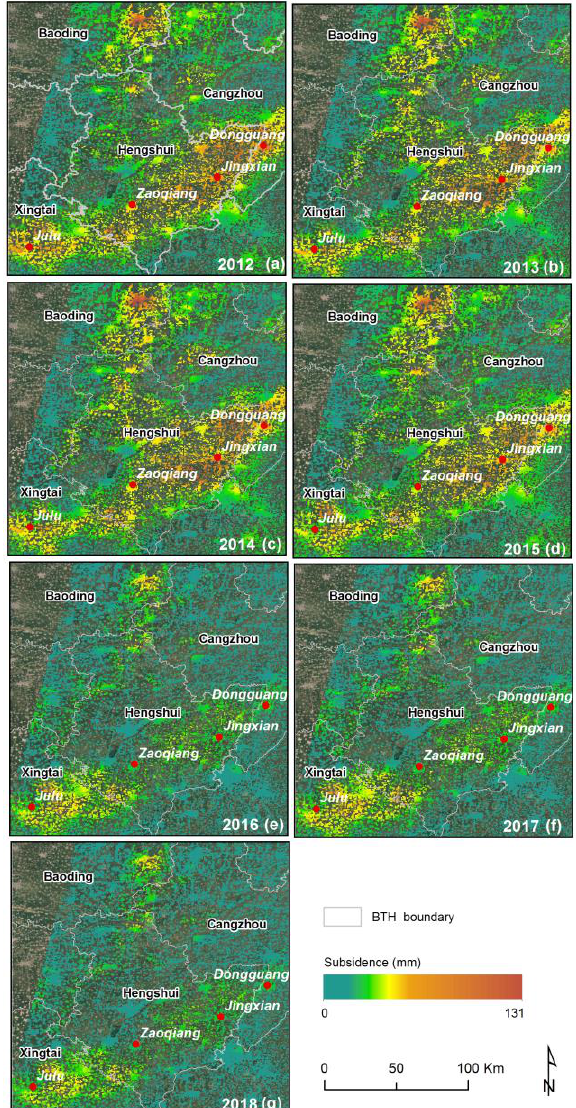
Figure 8. The annual land subsidence in typical Baoding, Hengshui and Xingtai regions. The subsidence in ( a – d ) is based on results from the Radarsat-2 data and ( e – g ) show results from the Sentinel-1 data. The four red circles are the locations of the subsidence features.